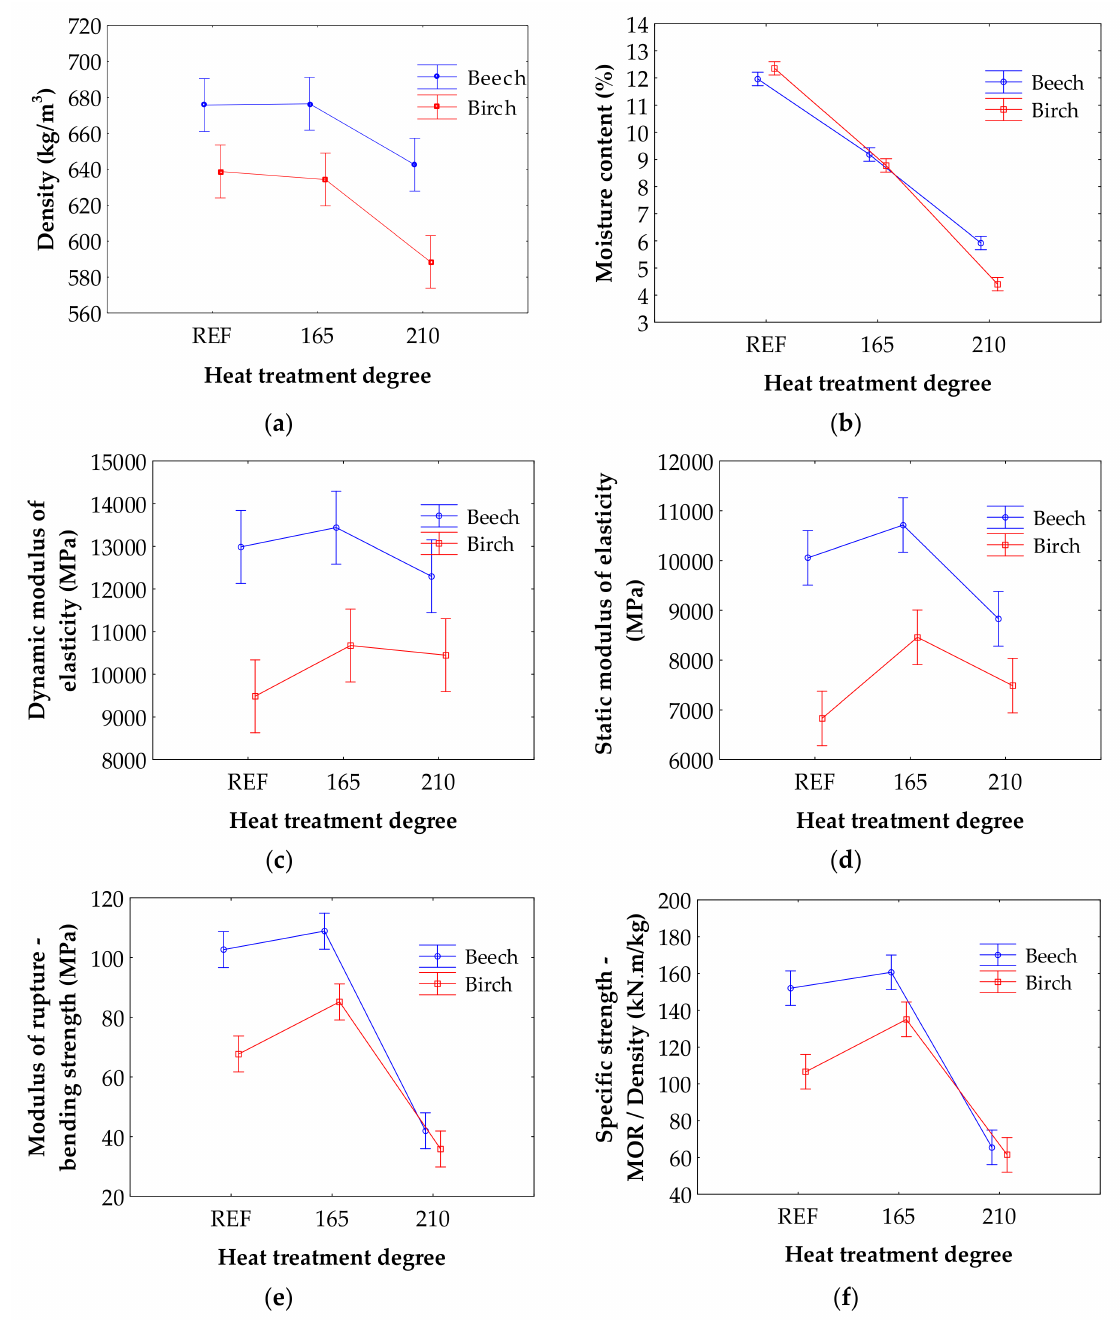
Figure 5. Graphic visualization of the effect of wood species and heat treatment temperature on ( a ) wood density; ( b ) moisture content; ( c ) dynamic elasticity modulus; ( d ) static elasticity modulus; ( e ) bending strength; and ( f ) specific strength for MOR, at a 95% significance level. MOE = Modulus of